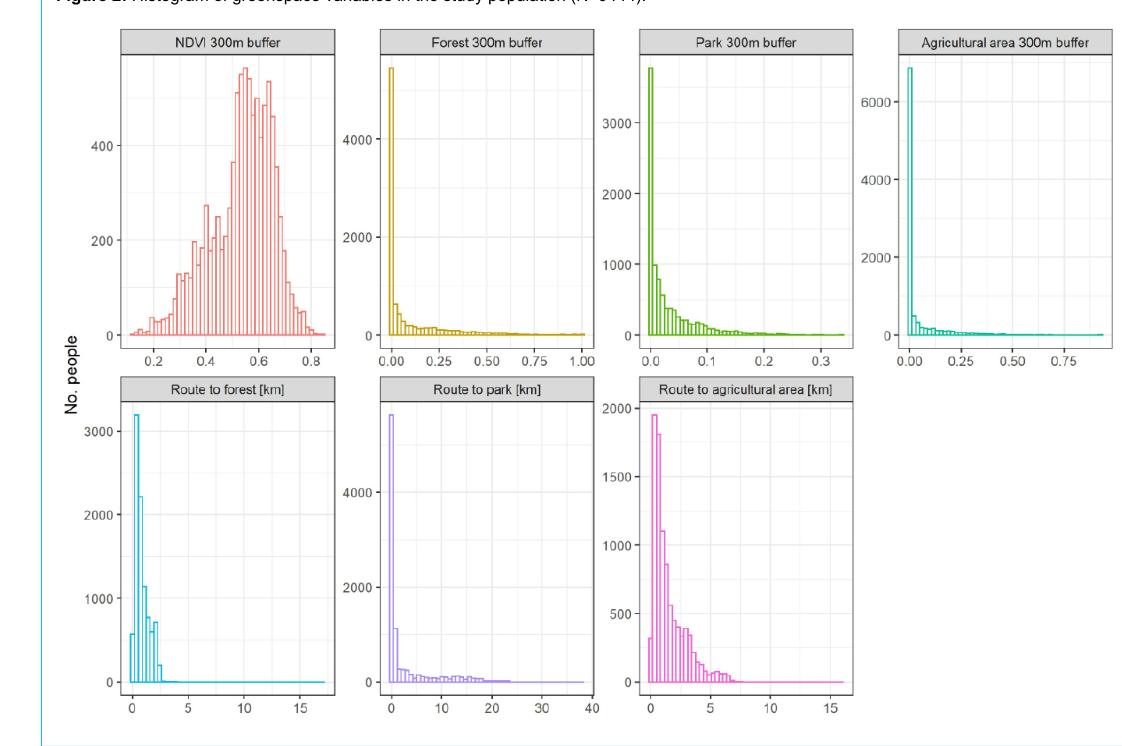
Figure 2: Histogram of greenspace variables in the study population